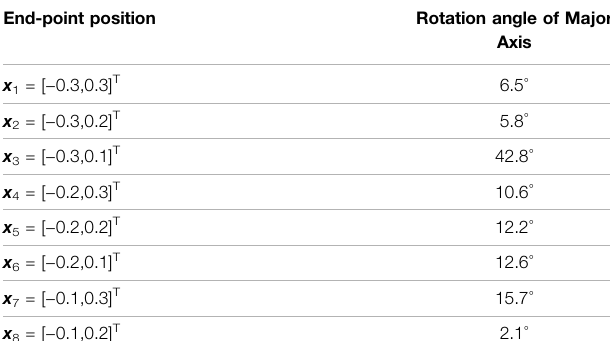
TABLE 3 | Major axis of ellipsoid as a function of end-point position. End-point